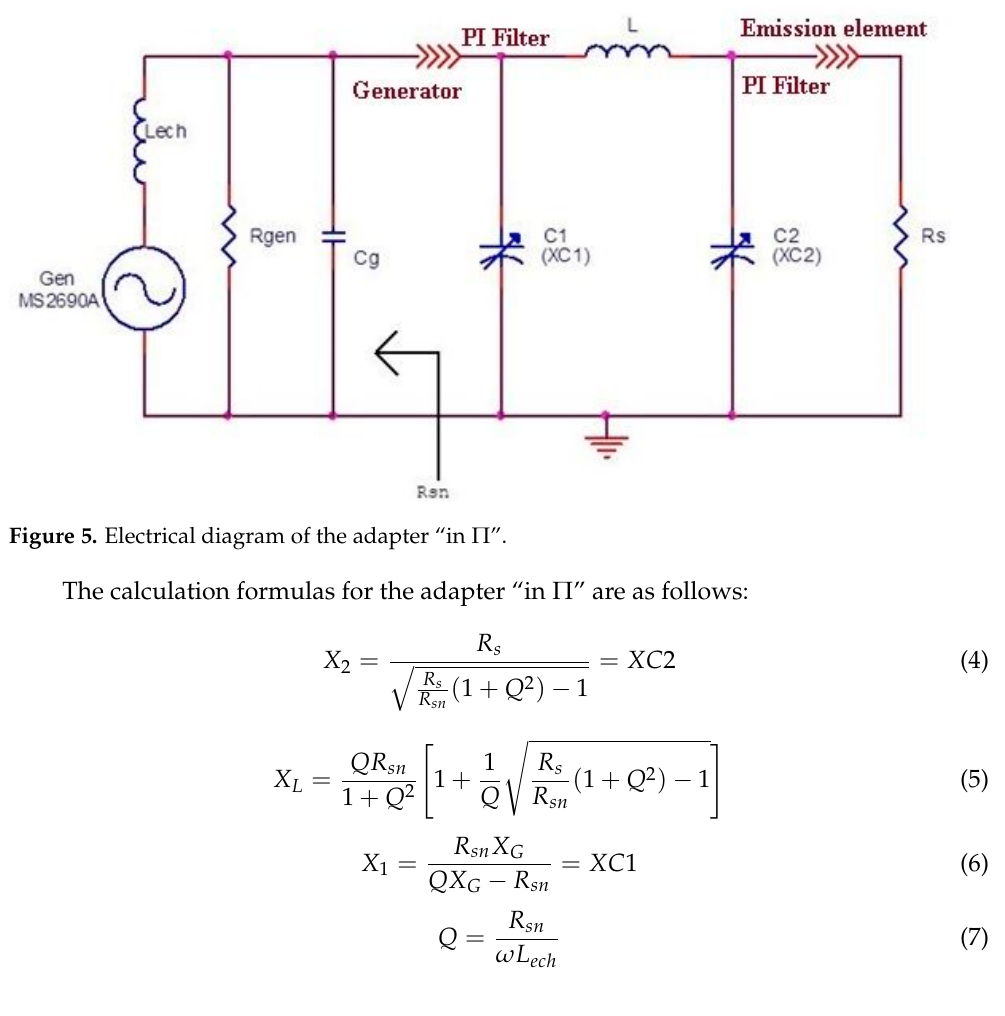
Figure 6. Practical mounting diagram for adjusting the impedance adapter “in Π ”. After the verifications carried out, practical measurements were made inside the mine. Measurements were made with the emission element and reception electromagnetic sensor placed in the air (Figure 7) and with them placed in saline environment for the vertical plane: the emission element introduced in saline environment (Figure 8), recep- tion electromagnetic sensor introduced in saline environment (Figure 9) and the measure- ment result for 187.5 MHz frequency (Figure 10).